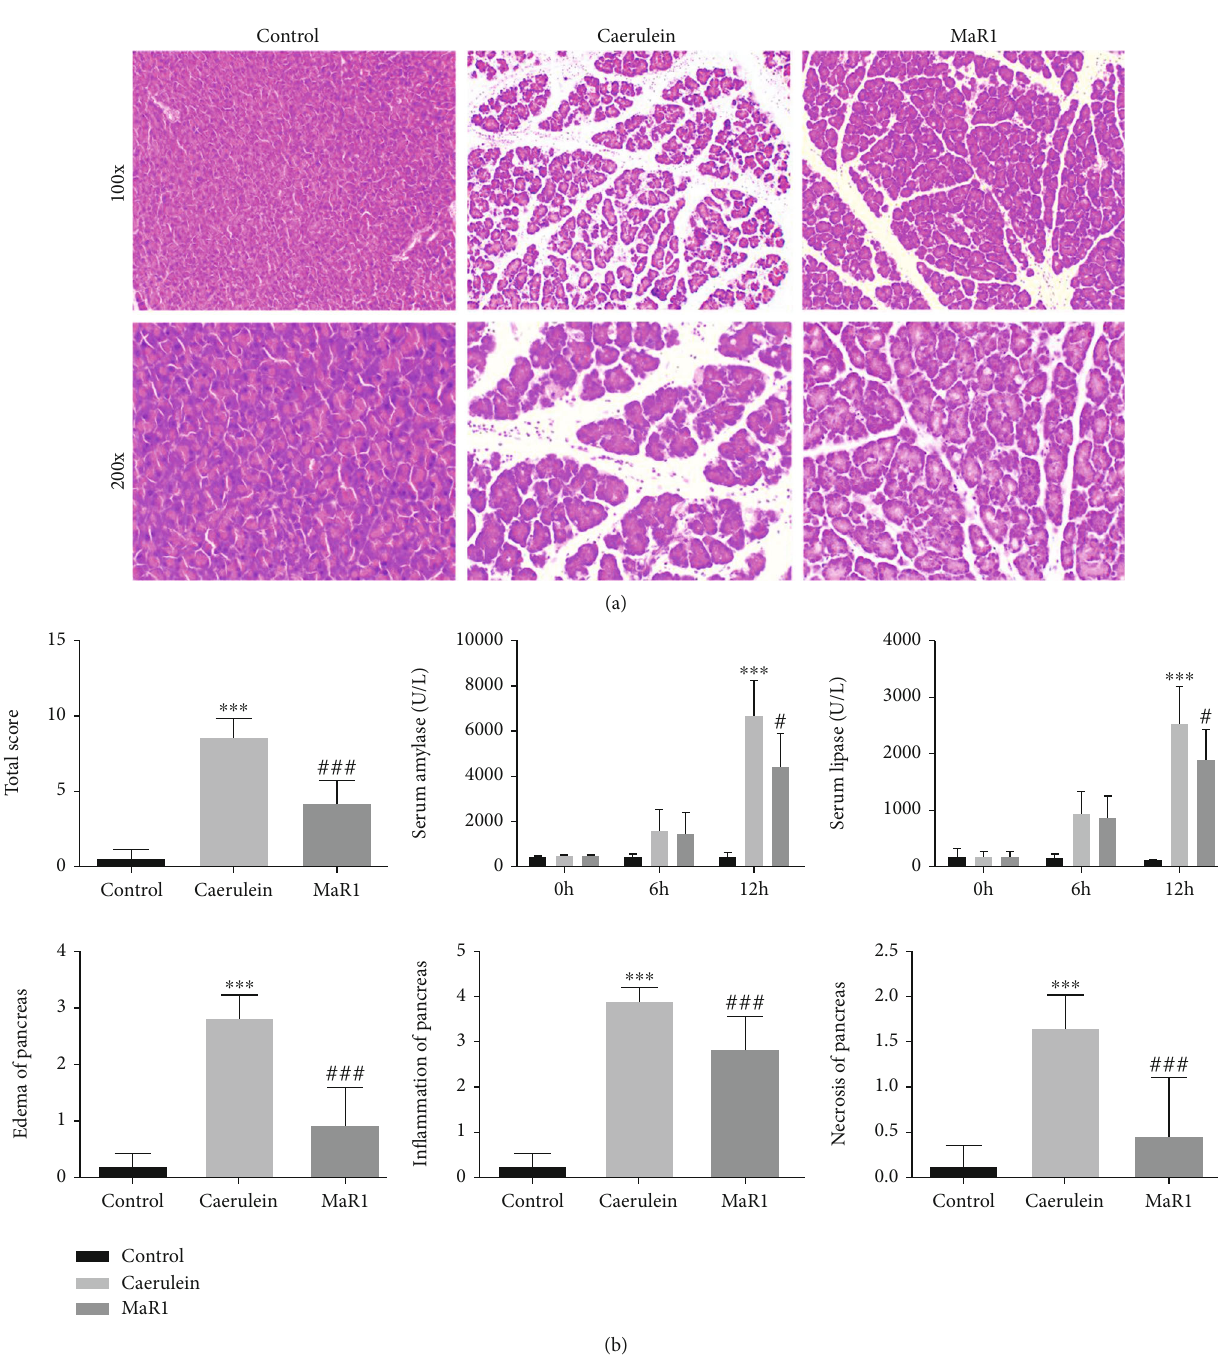
Figure 1: MaR1 ameliorated pancreatic tissue injury in AP mice. (a) Representative pathological changes in pancreas. HE stained sections of the pancreas in magni fi cation 100x and 200x. (b) Histological scores of pancreatic tissues (edema, in fl ammation, and necrosis) and serum levels of amylase and lipase. ∗∗∗ P < 0 : 001 vs. the control group. # P < 0 : 05 , ## P < 0 : 01 , and ### P < 0 : 001 vs. the caerulein group. n ≥ 6 each